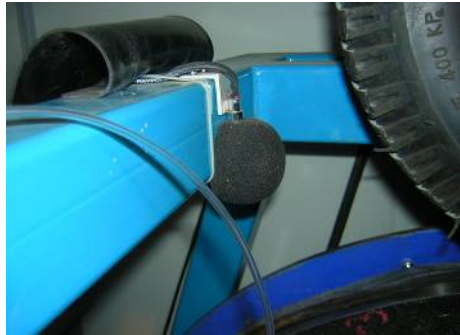
Figure 9. Microphone setting and noise signal analysis.